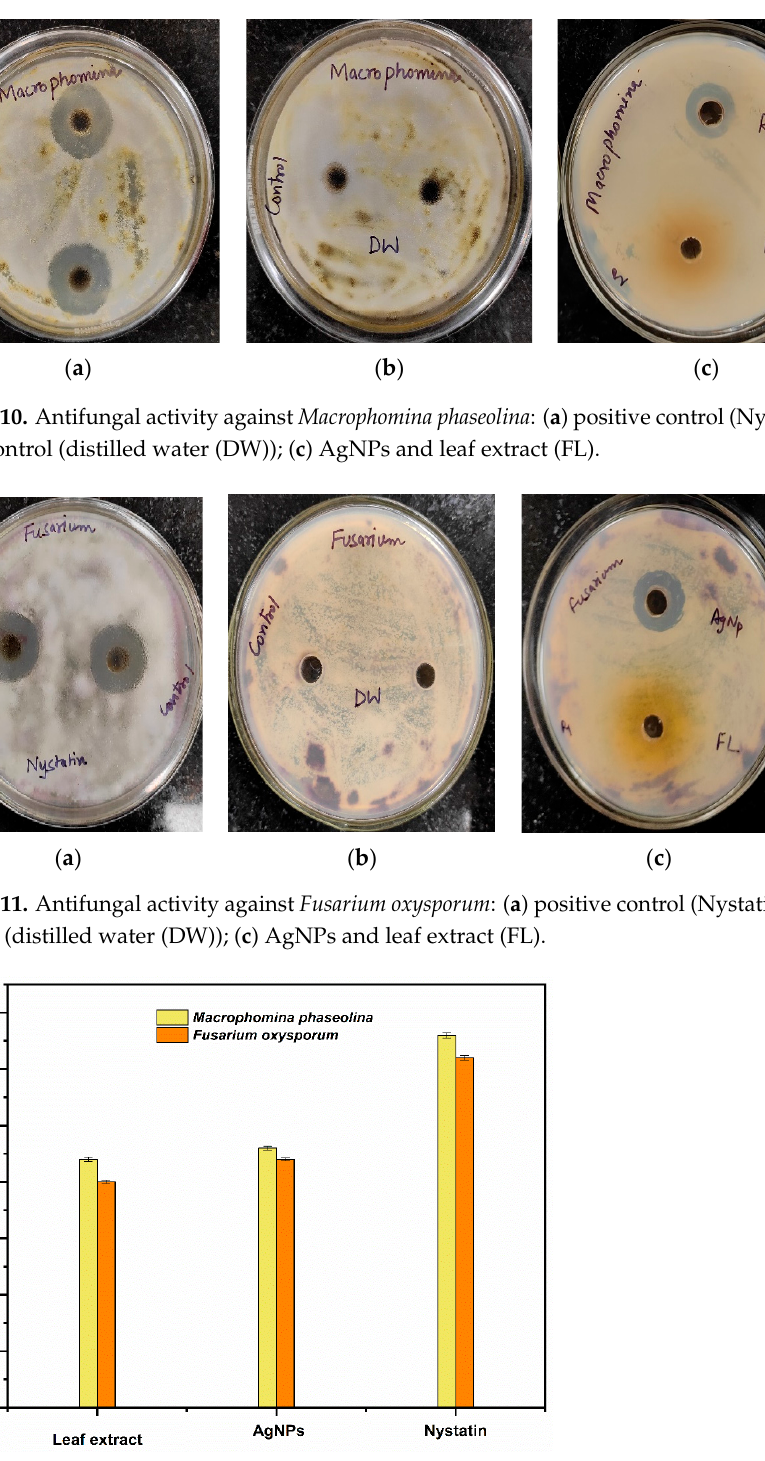
Figure 12. Comparison of the antifungal activity of the leaf extract and the biosynthesized AgNPs. Although AgNPs have an antibacterial effect, their impact on microbes and anti ‐ bacterial mechanisms is not well understood. Positively charged Ag ions interacted with negatively charged cell membranes, disrupting the shape of the cells and causing cell leakage, which ultimately caused cell death. The phosphorus and sulphur of the extra ‐ cellular and intracellular membrane proteins are also tightly bound by AgNPs, which affects cell replication, respiration, and ultimately the cell lifespan. In addition, AgNPs can interact with the thiol and amino groups of membrane proteins, forming reactive oxygen species (ROS) that prevent cells from respirating. AgNPs’ high bactericidal ac ‐ tivity is due to their interaction with the bacterial strain’s plasma membrane and pepti ‐ doglycan cell wall. Previous literature reported that the smaller ‐ size AgNPs showed higher antimicrobial activities due to the larger surface area [23,24]. 2.5. Antioxidant Activity 2.5.1. DPPH Free Radical Scavenging Activity By comparing the DPPH free radical scavenging percentage of the Trigonella foe ‐ num ‐ graecum L. leaf extract and the synthesized AgNPs with standard ascorbic acid, the antioxidant activity was determined. When the sample solution was added, it was no ‐ ticed that the color of the DPPH solution changed from purple to yellow. This was due to the scavenging of DPPH as a result of the hydrogen atom being donated to stabilize the DPPH molecule. The DPPH free radical scavenging activity of ascorbic acid was 92.51% at 120 μ g/mL followed by 88.21, 74.18, 61.42, 48.12, and 28.54% at 100, 80, 60, 40, and 20 μ g/mL concentration, respectively. The DPPH free radical scavenging activity of aqueous leaf extract was 90.42% at 1100 μ g/mL followed by 86.33, 70.18, 58.55, 36.72, and 18.41% at 900, 700, 500, 300, and 100 μ g/mL concentration, respectively, while the highest AgNP DPPH free radical scavenging activity was 92.81% at 1100 μ g/mL followed by 88.07, 72.19, 59.43, 39.56, and 19.64% at 900, 700, 500, 300, and 100 μ g/mL concentration, re ‐ spectively (Figure 13). As the concentration of the extract or AgNPs increases, the DPPH free radical scavenging activity increased. Ascorbic acid had an IC 50 of 54.33 μ g/mL, while AgNPs had an IC 50 of 426.25 μ g/mL, and aqueous leaf extract had an IC 50 of 432.50 μ g/mL, indicating that ascorbic acid had the highest antioxidant efficacy. AgNPs had higher antioxidant efficacy compared to the aqueous leaf extract. This might be due to the presence of phytochemicals on the surface of AgNPs, which facilitate rapid single elec ‐ tron and hydrogen atom transfer, thus stabilizing the DPPH molecule [25].